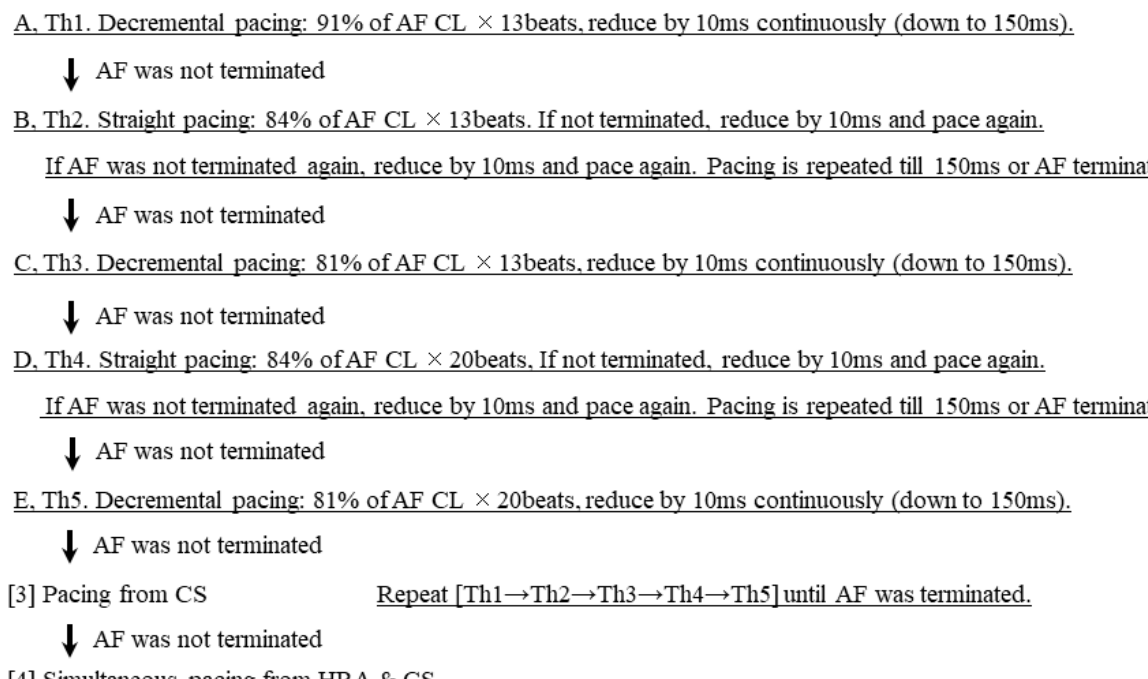
Figure 1. Pacing protocol of this study. AF = atrial fibrillation; CS = coronary sinus; CL = cycle length; HRA = high right atrium; Th = therapy.